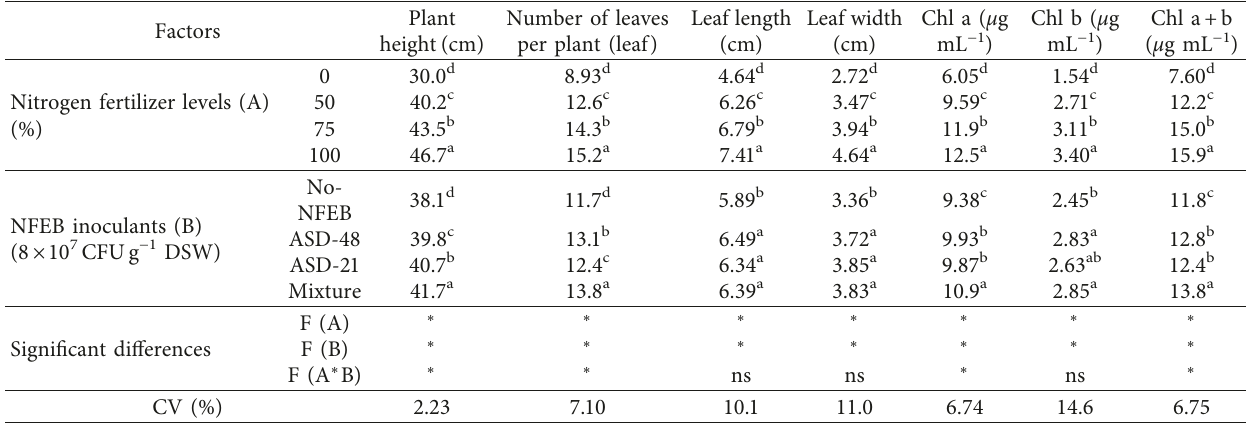
Figure 1: Effects of nitrogen fertilizer levels and nitrogen fixing endophytic bacteria supplementation, Enterobacter spp., on improvement of N uptake in sesame at harvest on alluvial soil in dykes. Table 4: Effects of nitrogen fertilizer levels and nitrogen fixing endophytic bacteria supplementation, Enterobacter spp., on growth of sesame cultivated on alluvial soil in dykes at